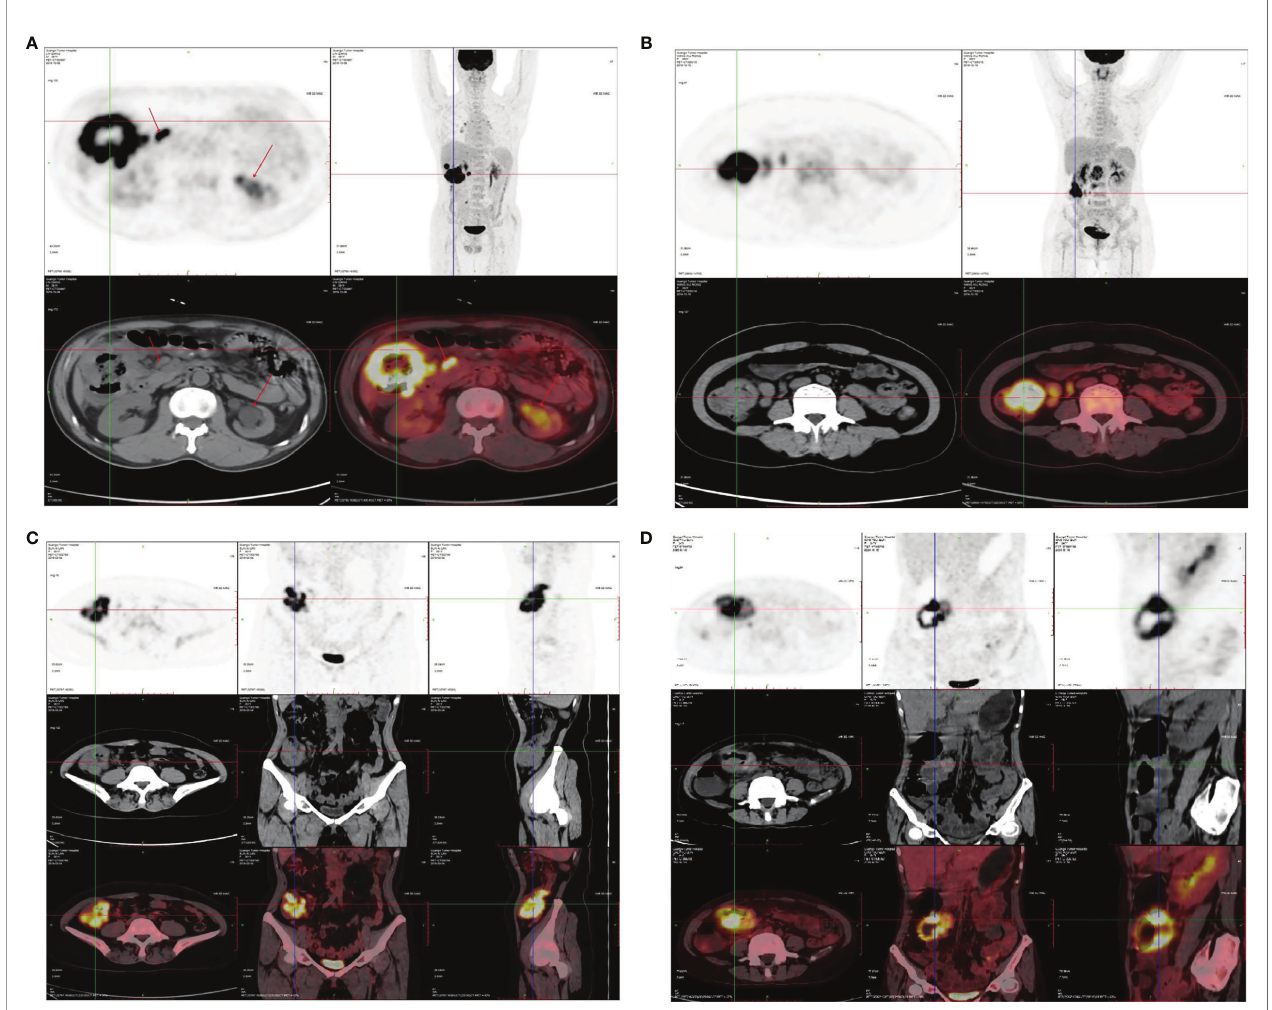
FIGURE 2 | Representative images 18 FDG-PET/CT scan on CRC patients. (A) Ascending colon, stage IV, SUVmax: 34.0. (B) Ascending colon, stage III, SUVmax: 19.9. (C) Transverse colon, stage II, SUVmax: 21.3. (D) Ascending colon, stage II, SUVmax: